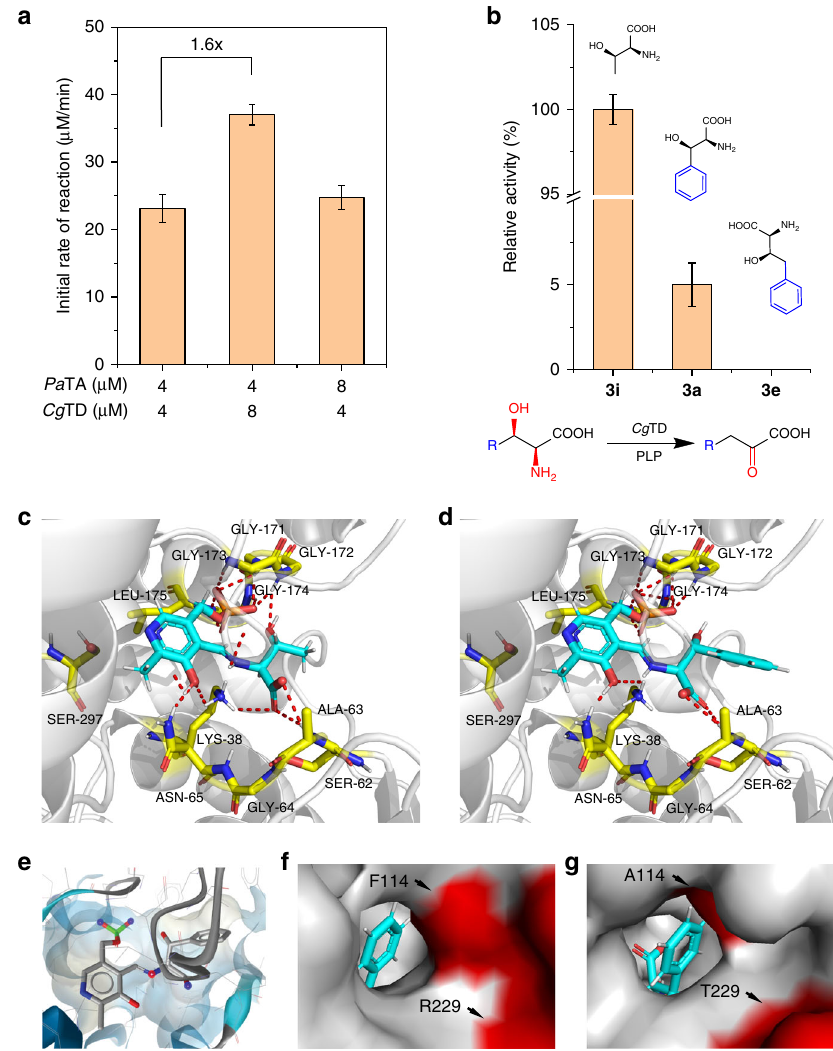
Fig. 3 Improvement of the substrate speci fi city of Cg TD toward bulky substrates by protein engineering. a The effect of TA and TD concentrations on the initial reaction rate of 1a to 4a (reactions were performed in duplicate with Pa TA and Cg TD enzymes, with 2.5 mM aldehydes, 25 mM glycine, and 50 µ M PLP). b Cg TD activity toward different substrates. c Docking of the PLP/ 3i complex into the active site of Cg TD. d Docking of the PLP/ 3a complex into the active site of Cg TD. e The surface of binding pocket. f Substrate access channel of Cg TD WT . g Substrate access channel of Cg TD F114A,R229T . All enzymatic assays were performed in triplicate, and error bars indicate